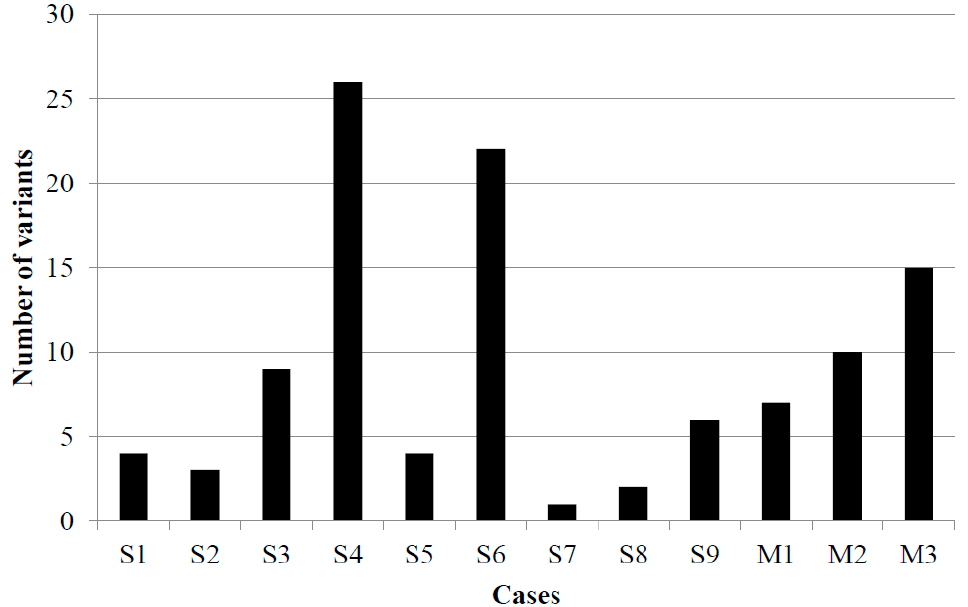
Figure 3. Variant tumor burden in nine Merkel cell carcinoma and three malignant melanoma cases. S1–S9: Merkel cell carcinoma samples, M1–M3: melanoma samples.